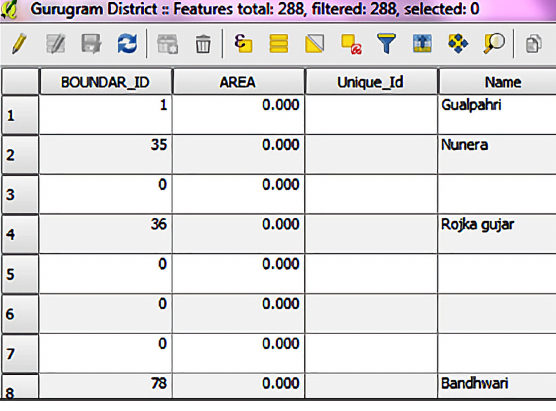
Fig. 8. Attribute table of spatial data.